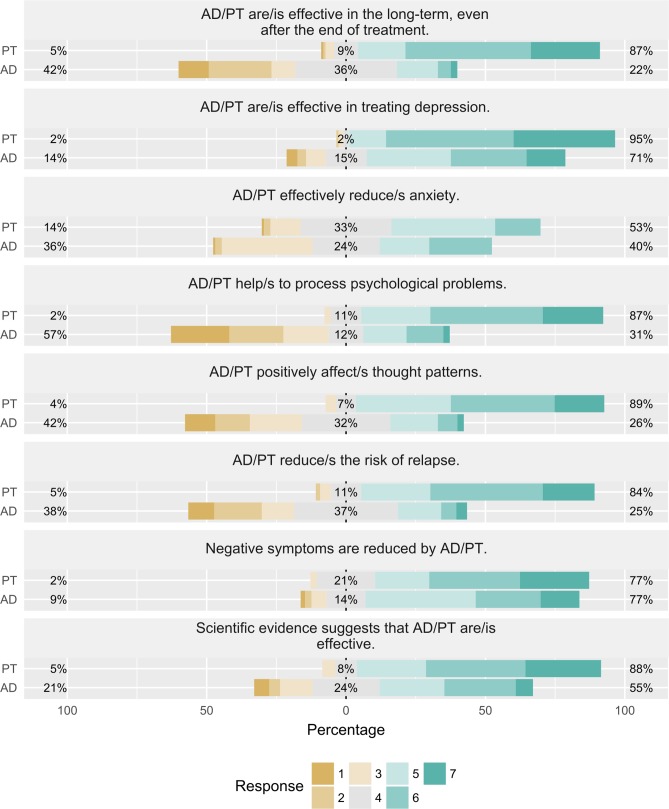
Treatment efficacy ratings for each item before navigation.